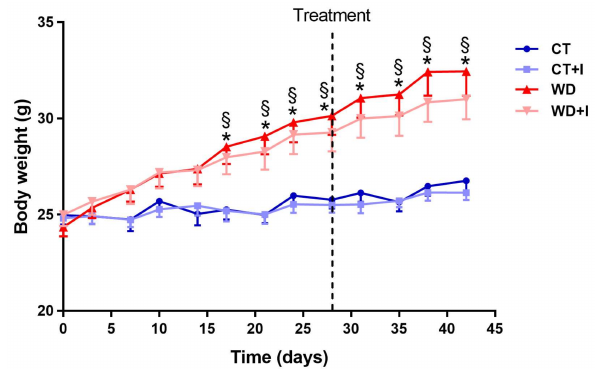
Figure 1. Body weight evolution. Inulin supplementation was introduced after 4 weeks. Data are presented as mean ± SEM and analyzed with a mixed model ANOVA followed by Tukey post hoc test. * p < 0.05 versus CT, § p < 0.05 versus CT + I.